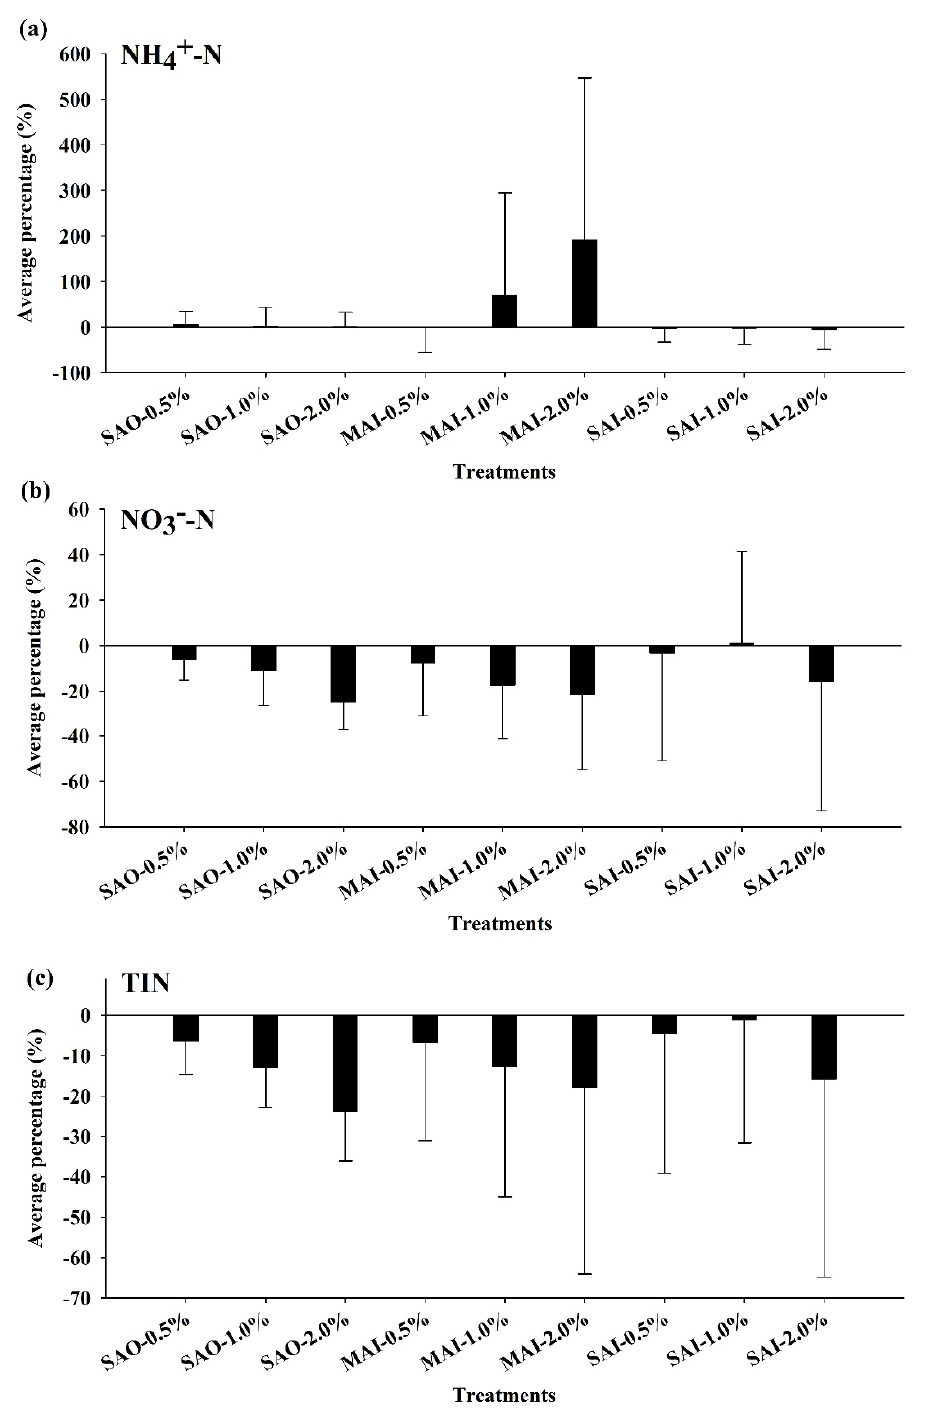
Figure 4. Average percentage (%) (22 times) of mean relative value of (a) NH 4+ -N, (b) NO 3− -N, and (c) total inorganic N (TIN) in three studied soils during a 371-day incubation. Percentage expressed as the difference between biochar amended treatments and un-amended control treatment. The data are mean value, and vertical bars represent standard deviations (SDs) of the means.